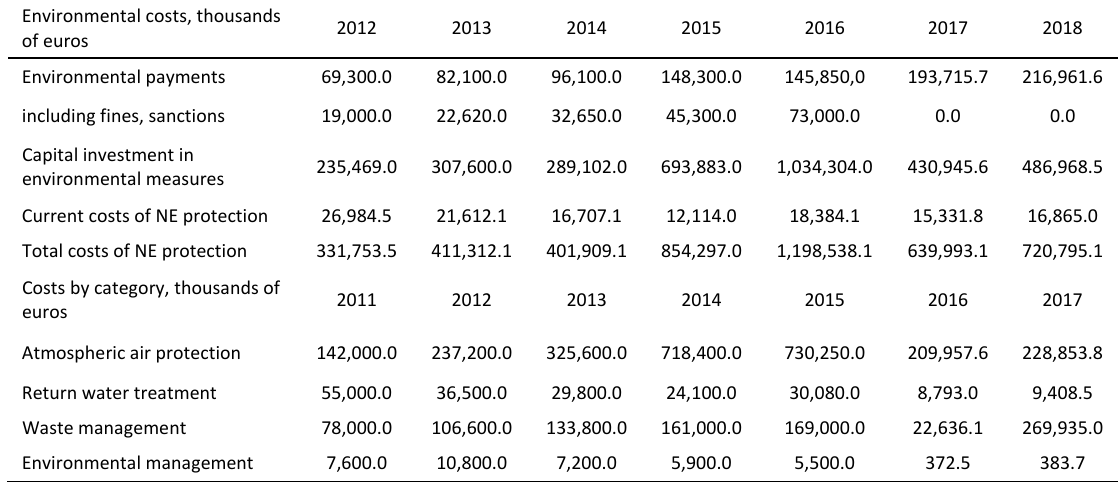
Table 4: Data for the analysis of the block of ecological initiative of the enterprise under study for 2012–2018